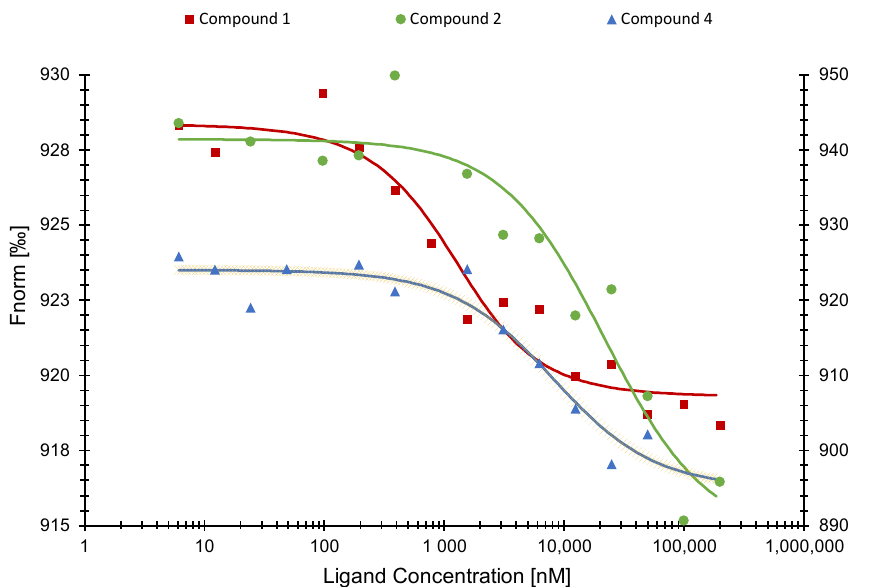
Figure 4. Binding curves of SARS-CoV-2 NP with compounds ( 1 ) ( left axis ), ( 2 ), and ( 4 ) ( right axis ) as determined by microscale thermophoresis.